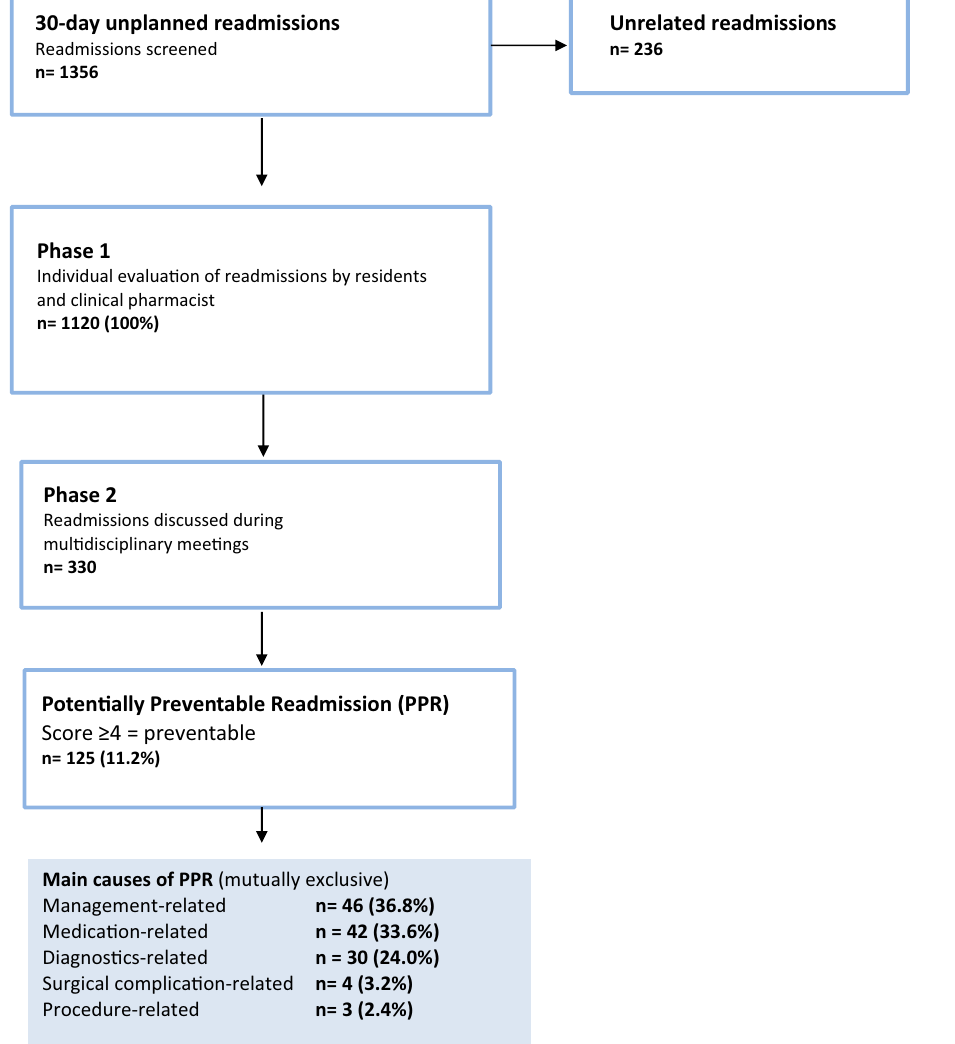
Figure 1. Flowchart readmission inclusion and final preventability